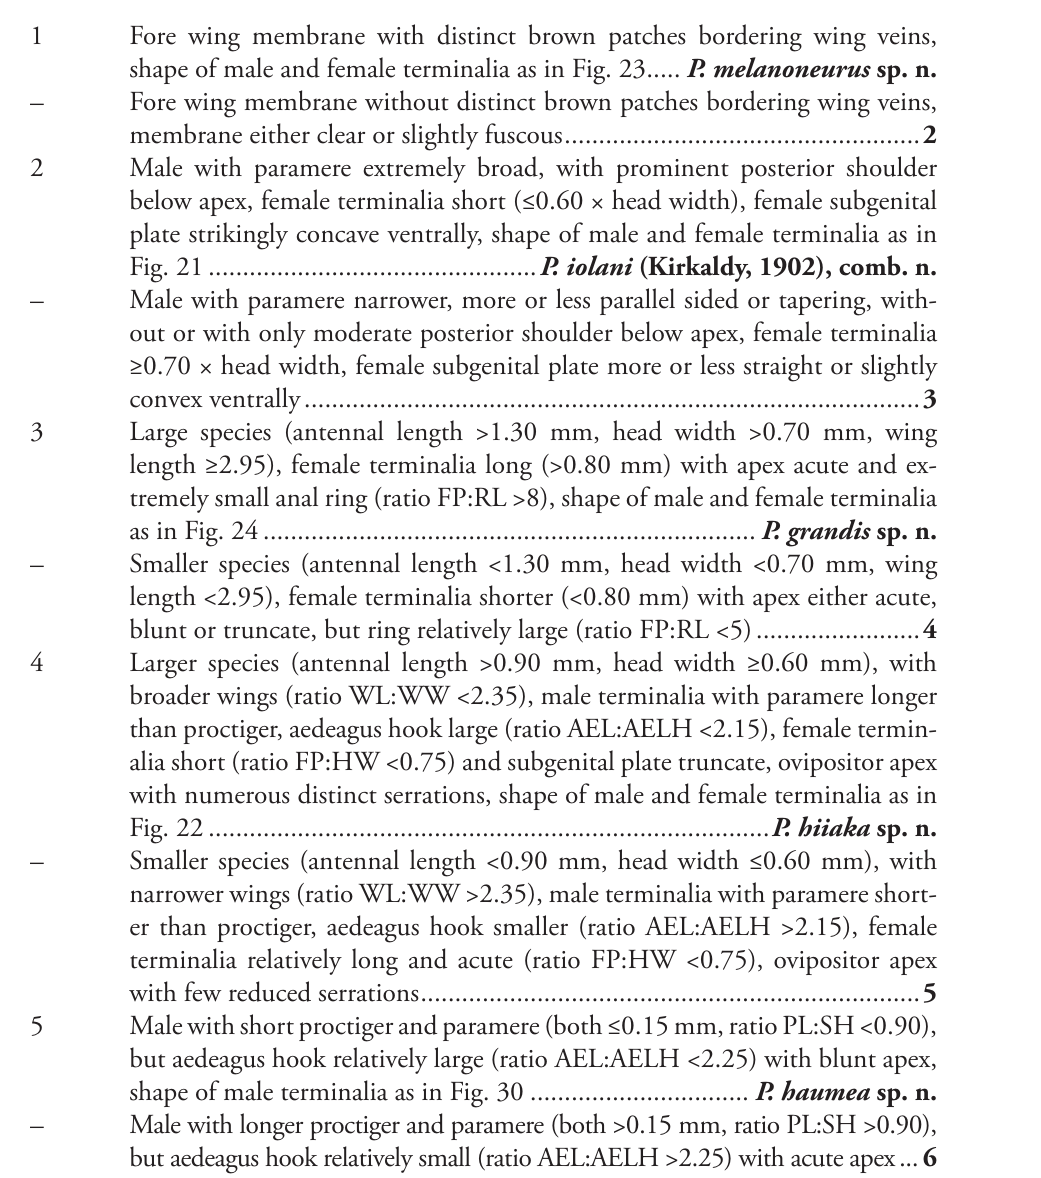
Adult key to Pariaconus species found on Kauai – kamua species group 1 Fore wing membrane with distinct brown patches bordering wing veins, shape of male and female terminalia as in Fig. 23 ..... P. melanoneurus sp. n. – Fore wing membrane without distinct brown patches bordering wing veins, membrane either clear or slightly fuscous .................................................... 2 2 Male with paramere extremely broad, with prominent posterior shoulder below apex, female terminalia short (≤0.60 × head width), female subgenital plate strikingly concave ventrally, shape of male and female terminalia as in Fig. 21 ................................................ P. iolani (Kirkaldy, 1902), comb. n. Male with paramere narrower, more or less parallel sided or tapering, with- out or with only moderate posterior shoulder below apex, female terminalia ≥0.70 × head width, female subgenital plate more or less straight or slightly convex ventrally .......................................................................................... 3 3 Large species (antennal length >1.30 mm, head width >0.70 mm, wing length ≥2.95), female terminalia long (>0.80 mm) with apex acute and ex- tremely small anal ring (ratio FP:RL >8), shape of male and female terminalia as in Fig. 24 ........................................................................ P. grandis sp. n. – Smaller species (antennal length <1.30 mm, head width <0.70 mm, wing length <2.95), female terminalia shorter (<0.80 mm) with apex either acute, blunt or truncate, but ring relatively large (ratio FP:RL <5) ........................ 4 4 Larger species (antennal length >0.90 mm, head width ≥0.60 mm), with broader wings (ratio WL:WW <2.35), male terminalia with paramere longer than proctiger, aedeagus hook large (ratio AEL:AELH <2.15), female termin- alia short (ratio FP:HW <0.75) and subgenital plate truncate, ovipositor apex with numerous distinct serrations, shape of male and female terminalia as in Fig. 22 .................................................................................. P. hiiaka sp. n. Smaller species (antennal length <0.90 mm, head width ≤0.60 mm), with narrower wings (ratio WL:WW >2.35), male terminalia with paramere short- er than proctiger, aedeagus hook smaller (ratio AEL:AELH >2.15), female terminalia relatively long and acute (ratio FP:HW <0.75), ovipositor apex with few reduced serrations ......................................................................... 5 5 Male with short proctiger and paramere (both ≤0.15 mm, ratio PL:SH <0.90), but aedeagus hook relatively large (ratio AEL:AELH <2.25) with blunt apex, shape of male terminalia as in Fig. 30 ................................ P. haumea sp. n. – Male with longer proctiger and paramere (both >0.15 mm, ratio PL:SH >0.90), but aedeagus hook relatively small (ratio AEL:AELH >2.25) with acute apex ...